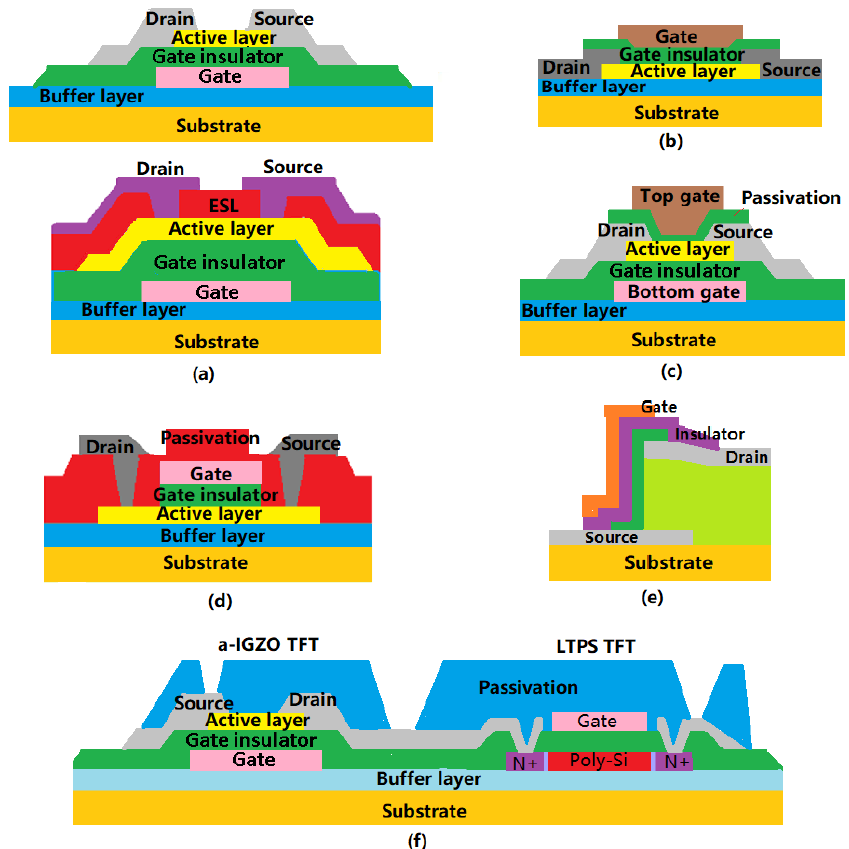
Figure 1. Typical device configurations of oxide semiconductors: ( a ) Back channel etch (BCE) and etch stop (ES) structure, ( b ) Top gate (TG) structure, ( c ) Dual gate (DG) structure, ( d ) Co-planar (CP) structure, ( e ) Vertical structure, and ( f ) Hybrid structure of LTPO.